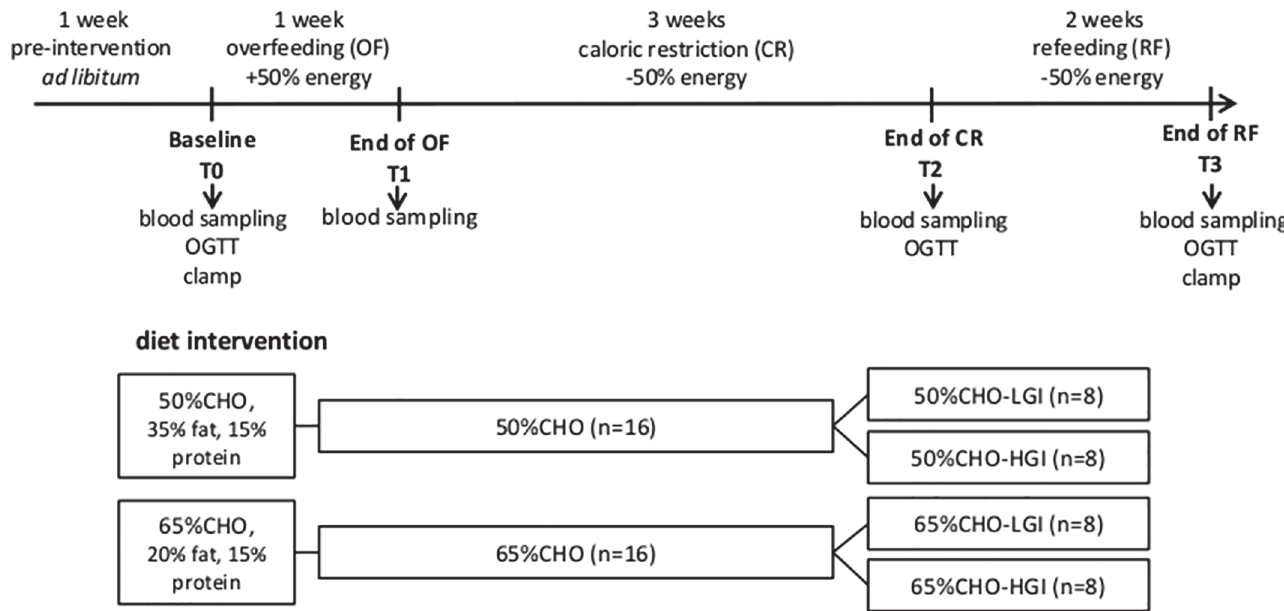
Fig 2. Schematic overview of the study protocol. OGTT, oral glucose tolerance test, CHO, carbohydrate; LGI, low glycaemic index; HGI, high glycaemic index